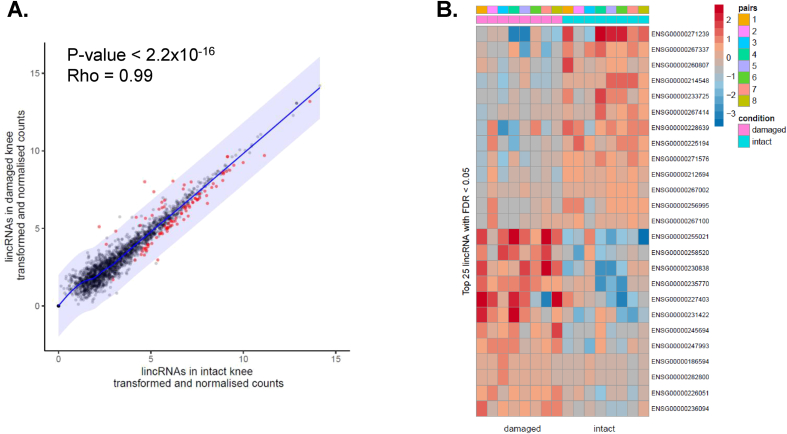
Differential lincRNA expression in paired OA-intact (PLC) compared to OA-damaged DMC) knee cartilage. A. Scatter plot of lincRNA counts in OA knee intact vs damaged RNA-seq. Significant lincRNAs (DESeq2, FDR < 0.05) are coloured in red, the shading represents a log2 fold change of 2 from the regression line. A Spearmans rank test was used to assess the correlation between samples. B. Heatmap of top 25 differentially expressed lncRNAs in damaged (pink) vs intact (cyan) knee OA RNA-seq samples. Patient pairings are indicated (1–8).